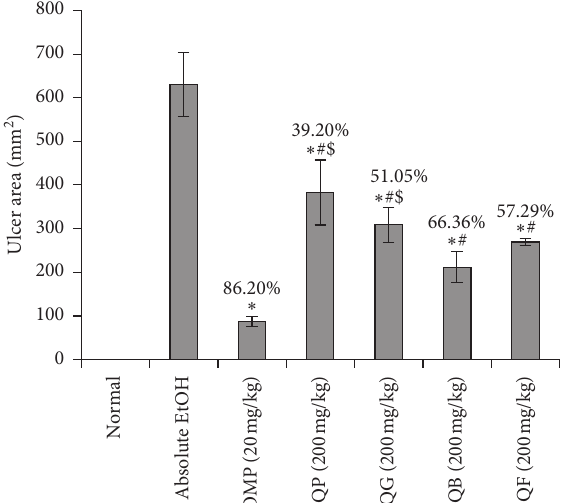
Figure 2: Effect of oral doses of 200mg/kg of QP (quinoa seeds cooked under high pressure), QG (first stage-germinated quinoa seeds), QB (quinoa seeds fermented by Lactobacillus plantarum bacteria), and QF (quinoa seeds fermented by Rhizopus oligosporus fungus) on the ulcer index induced by absolute ethanol (absolute EtOH, 5mL/kg) and in comparison to the reference omeprazole (OMP, 20mg/kg). ∗ p < 0 . 05 compared to absolute EtOH. # p < 0 . 05 compared to omeprazole OMP. $ p < 0 . 05 compared to QB. The percentages of ulcer area inhibition are recorded on the